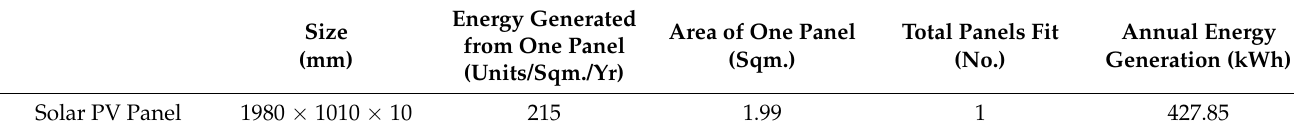
Table 7. Annual energy generation from the solar PV